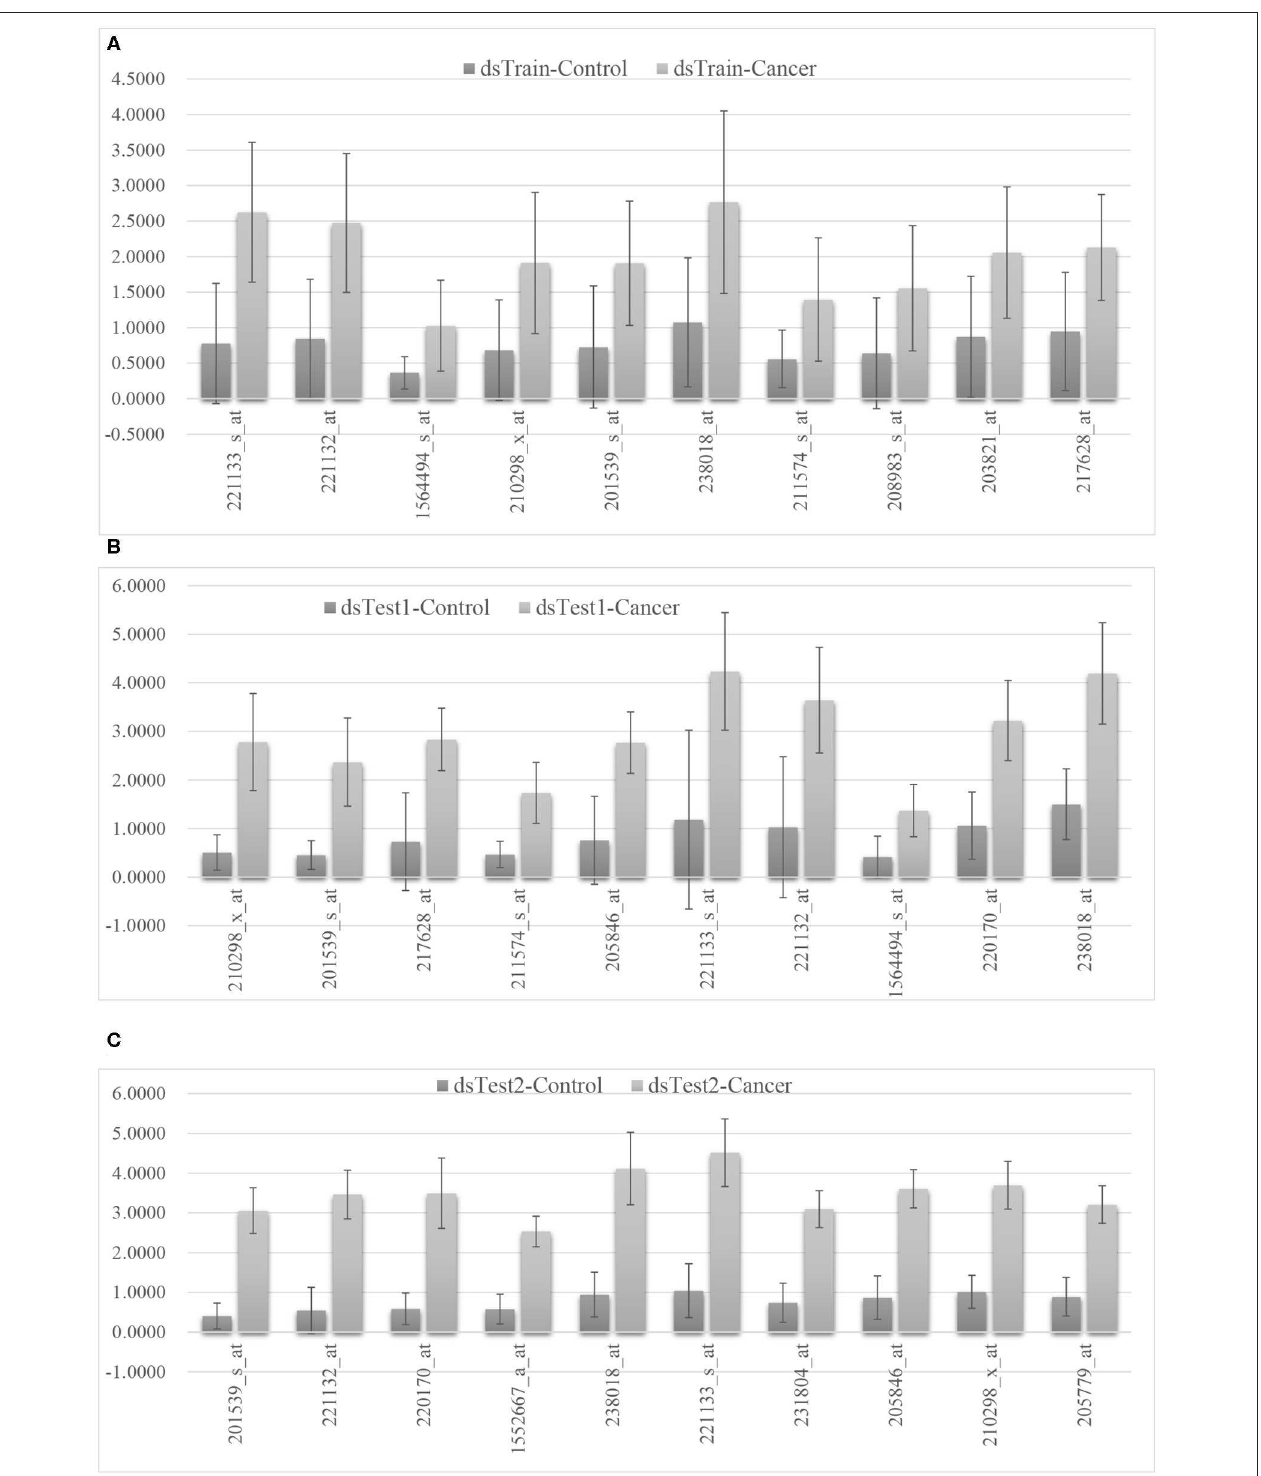
FIGURE 4 | The distributions of the 10 mqTrans features in the control and lung cancer samples. The mean and standard deviation values of the calculated mqTrans features in the dataset (A) dsTrain, (B) dsTest1, and (C) dsTest2. The top 10 mqTrans features were ranked by the ratio of the mean value of mqTrans features between the cancer group and the control